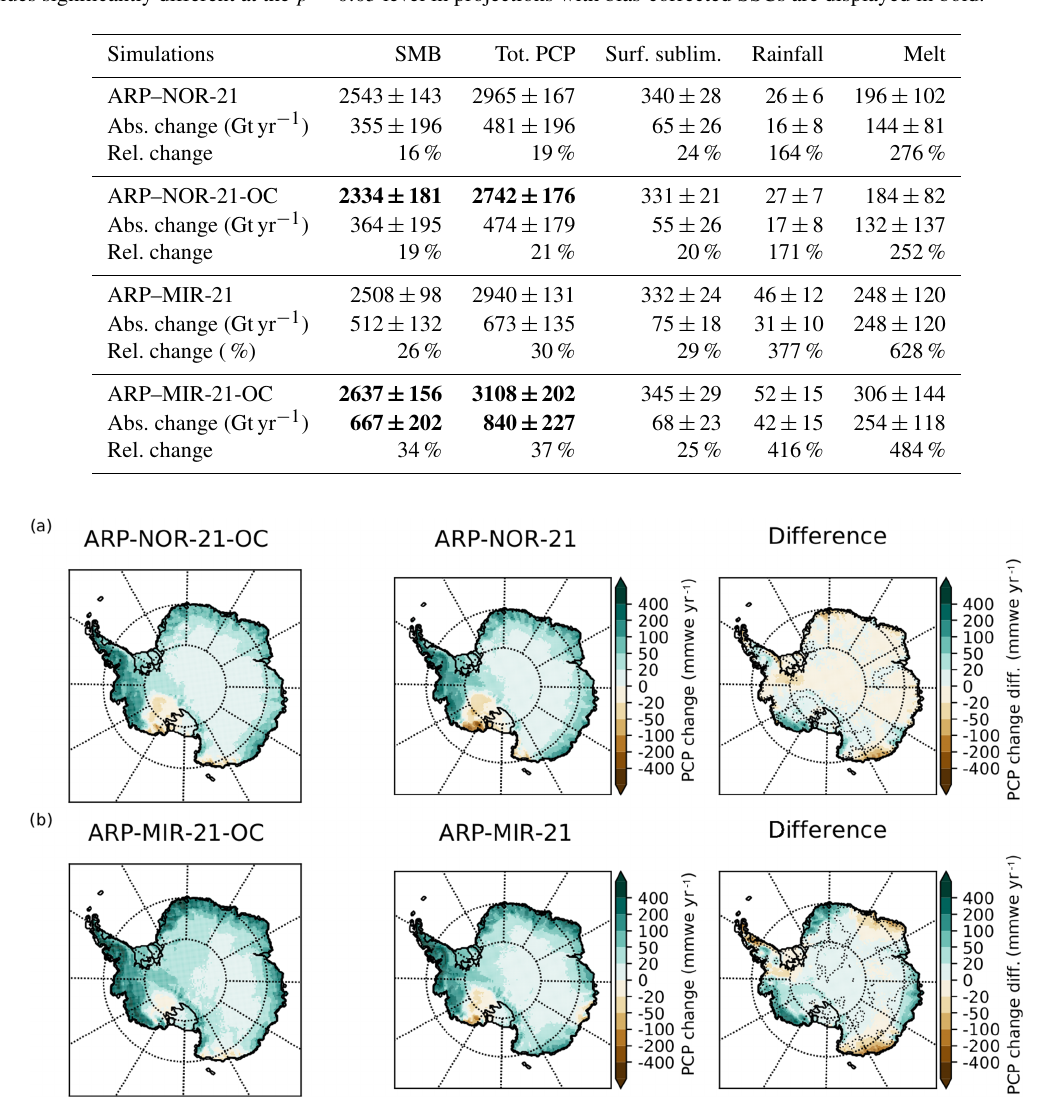
Figure 8. Climate change signal in total precipitation (mmw.e.yr − 1 ) for the late 21st century (reference period: 2071–2100) in the ARPEGE RCP8.5 projection with bias-corrected SSCs (left), original SSCs (centre) and the difference (right). Results for projections with SSCs from NorESM1-M are presented in panel (a) and from MIROC-ESM in panel (b) . Dotted lines indicate where the difference is 50% of the precipitation change in the non bias-corrected SSC